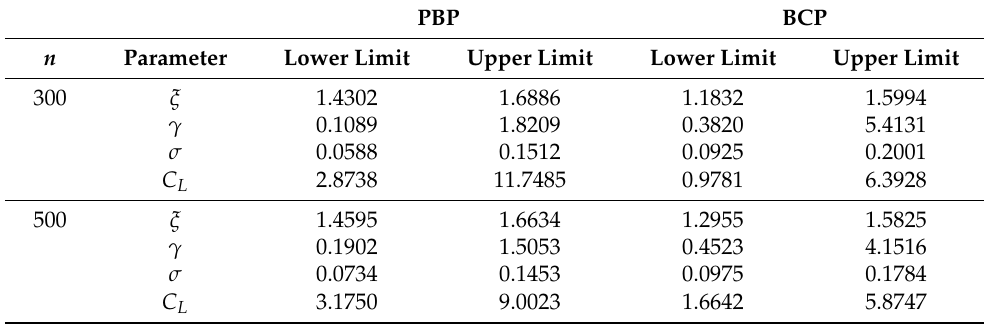
Table 3. The 95% bootstrap confidence intervals based on the merged sample with n = 300 and 500.